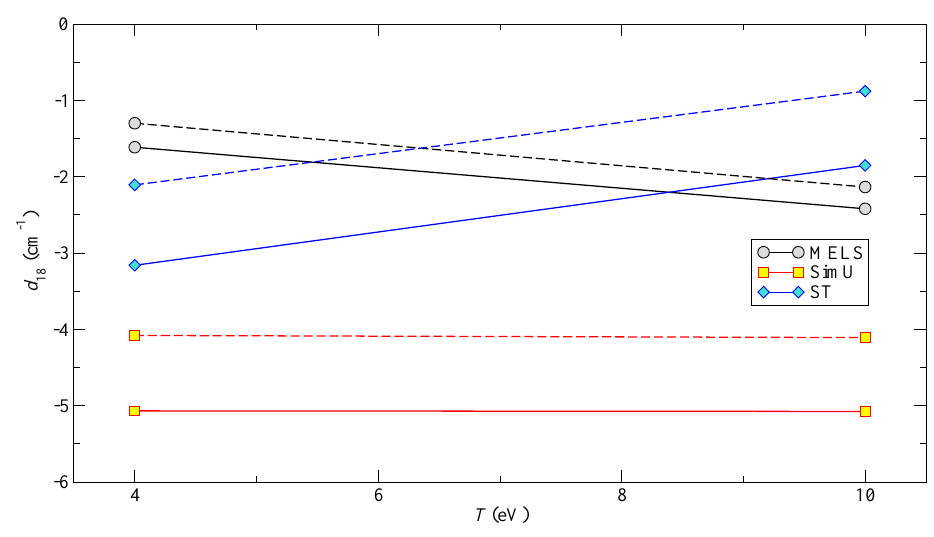
Figure 7. Calculated Stark shift per electron density of 10 18 cm − 3 as a function of plasma temperature. Solid lines: n e = 10 18 cm − 3 ; dashed lines: n e = 10 19 cm − 3 .